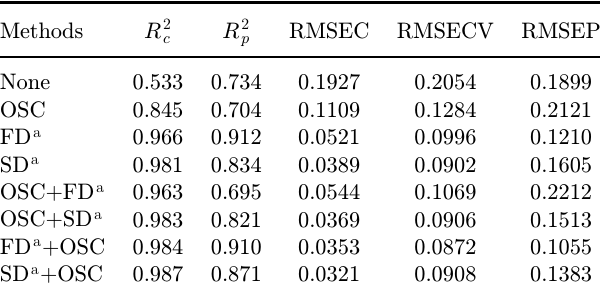
Fig. 2. Principal component score scatter plot of PC1 versus PC2. Table 2. Model results of di®erent pre-processing